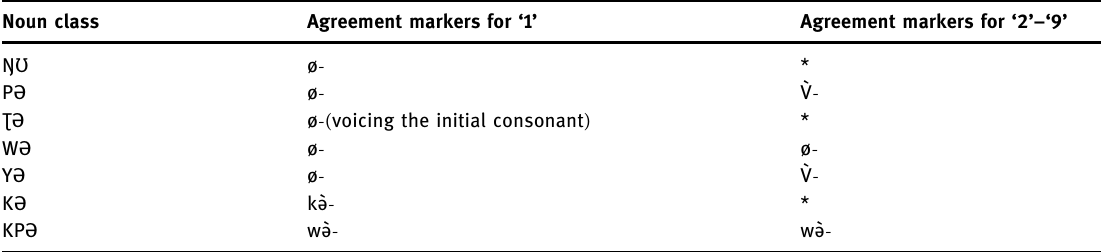
Table 3: Noun class agreement pre fi xes of Akebu simple numerals from ‘ 1 ’ to ‘ 9 ’